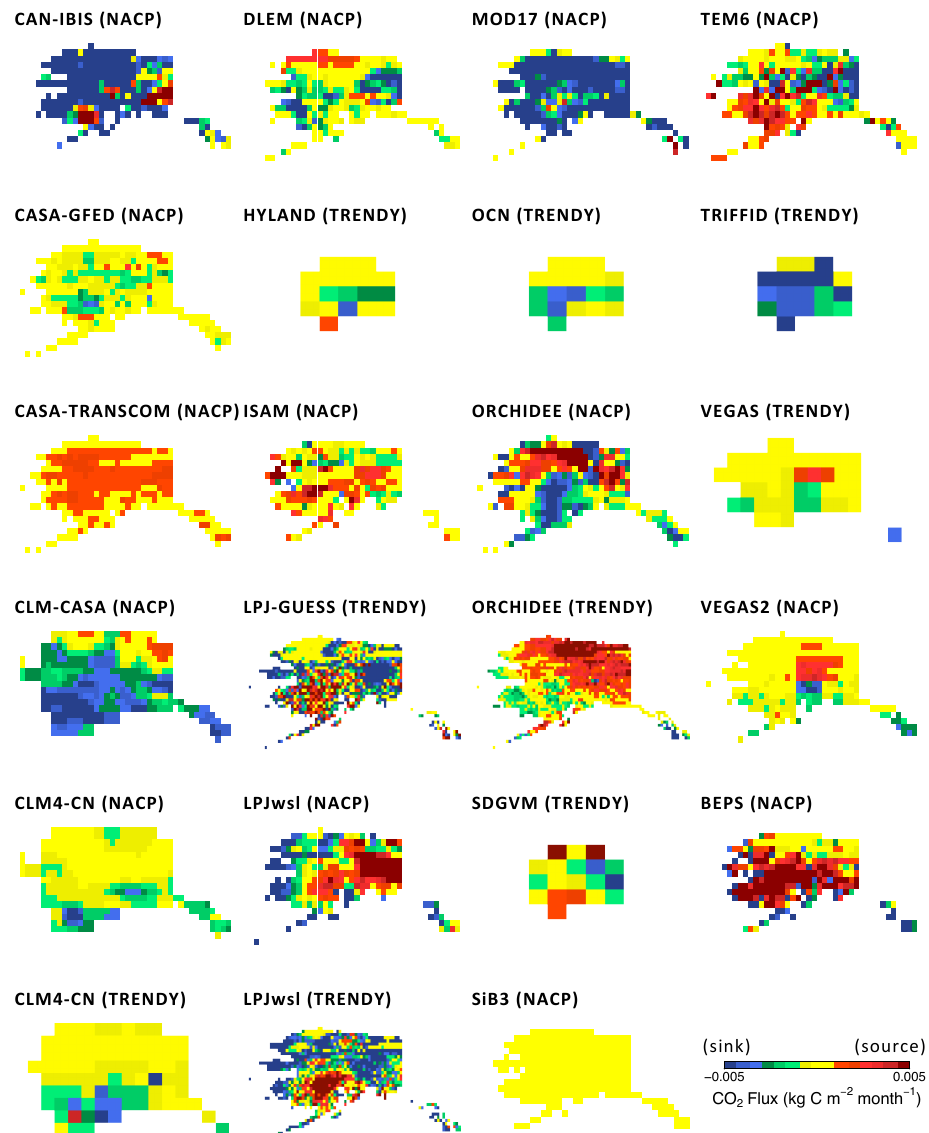
Figure 2. Mean annual (2003) net CO 2 flux for Alaska. Model output was part of the TRENDY (common forcing) and NACP regional (variable forcing) syntheses. 946